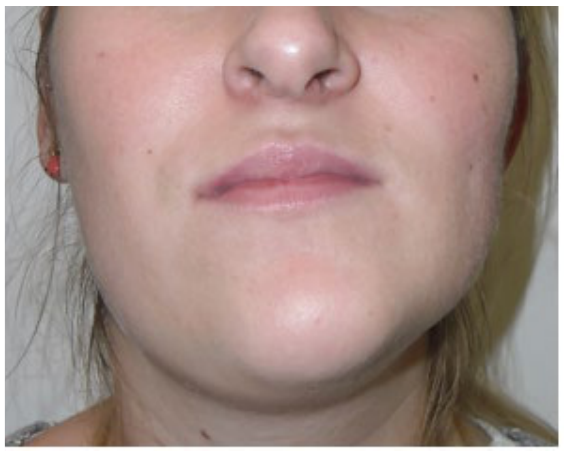
Figure 1. Typical facial appearance of UCH. A notable elongation and overgrowth of the right side of the face with chin asymmetry is visible. Changes in proportions of mouth angles are clearly visible along with the different positions of mandibular gonial diameters .